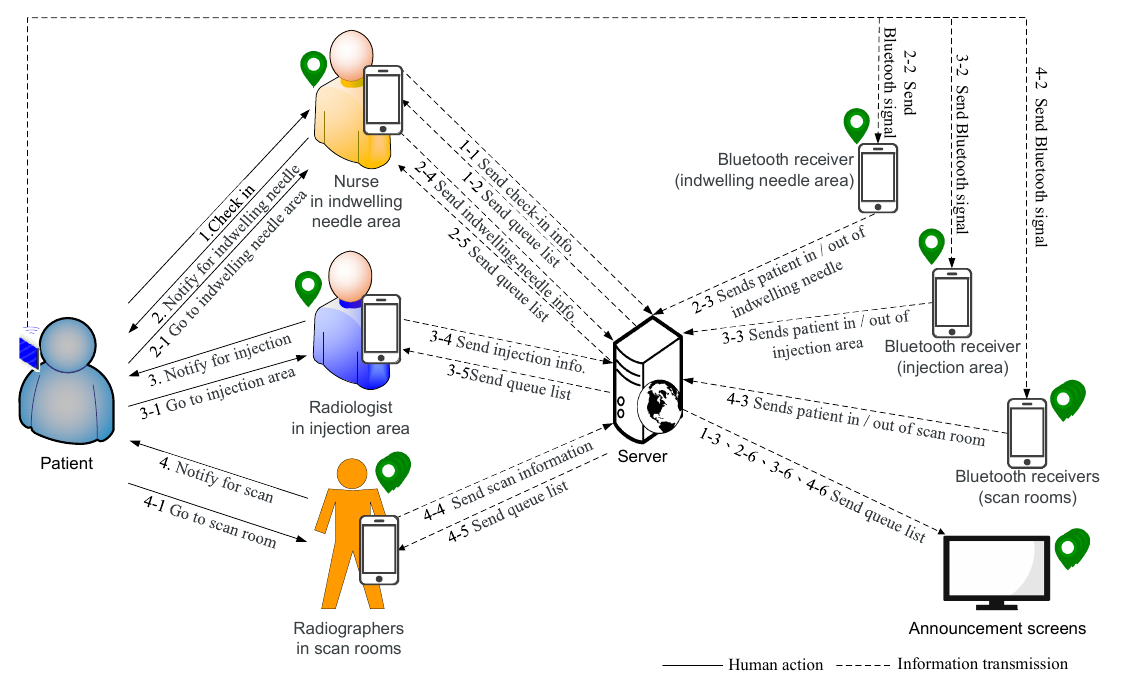
Figure 2. Schematic of automatic scheduling system.